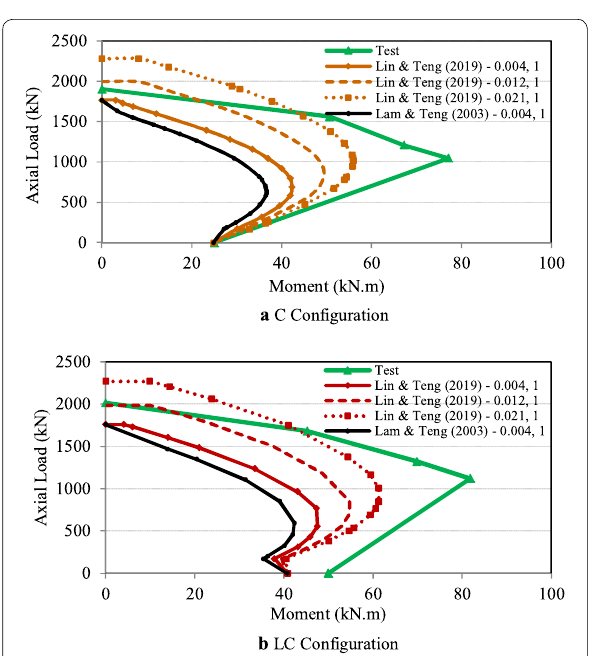
Fig. 12 Interaction diagrams for FRP‑ jacketed columns obtained using Lin and Teng (2019) model for effective FRP strains of 0.004, 0.012 and 0.021; and UASR of 1.